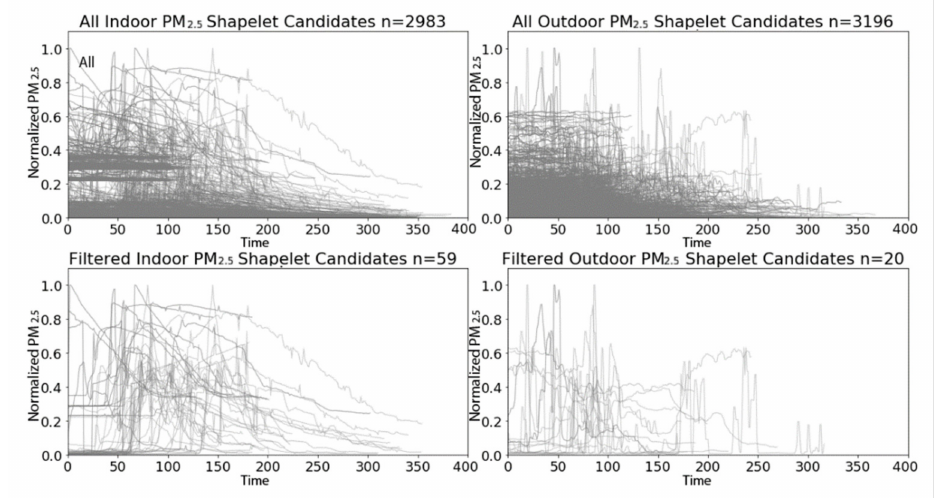
Figure 9. W-TSS shapelets for the PRISMS indoor and outdoor PM2.5 time series, before filtering ( top row ) and after filtering ( bottom row